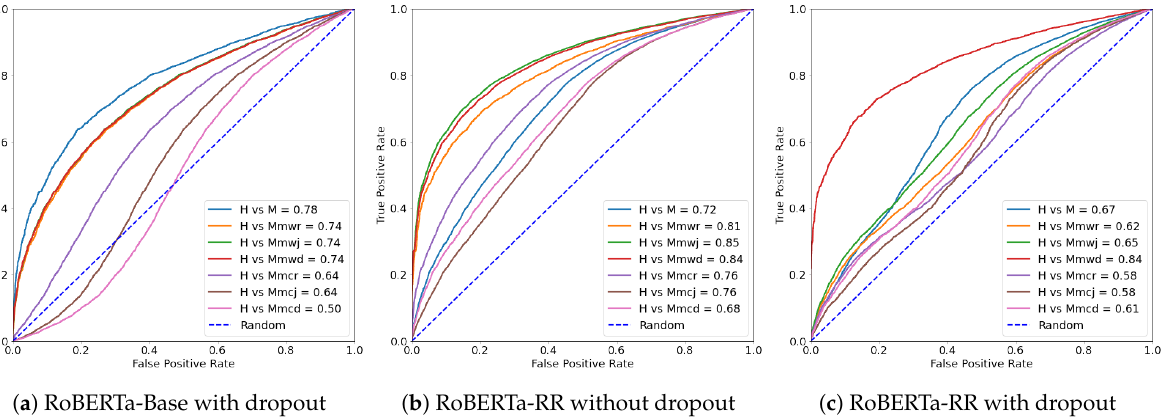
Figure 6. The area under the receiver operating characteristic curve for RoBERTa-Base, RoBERTa-RR without random dropout and RoBERTa-RR with 30% random dropout (i.e., dropout =